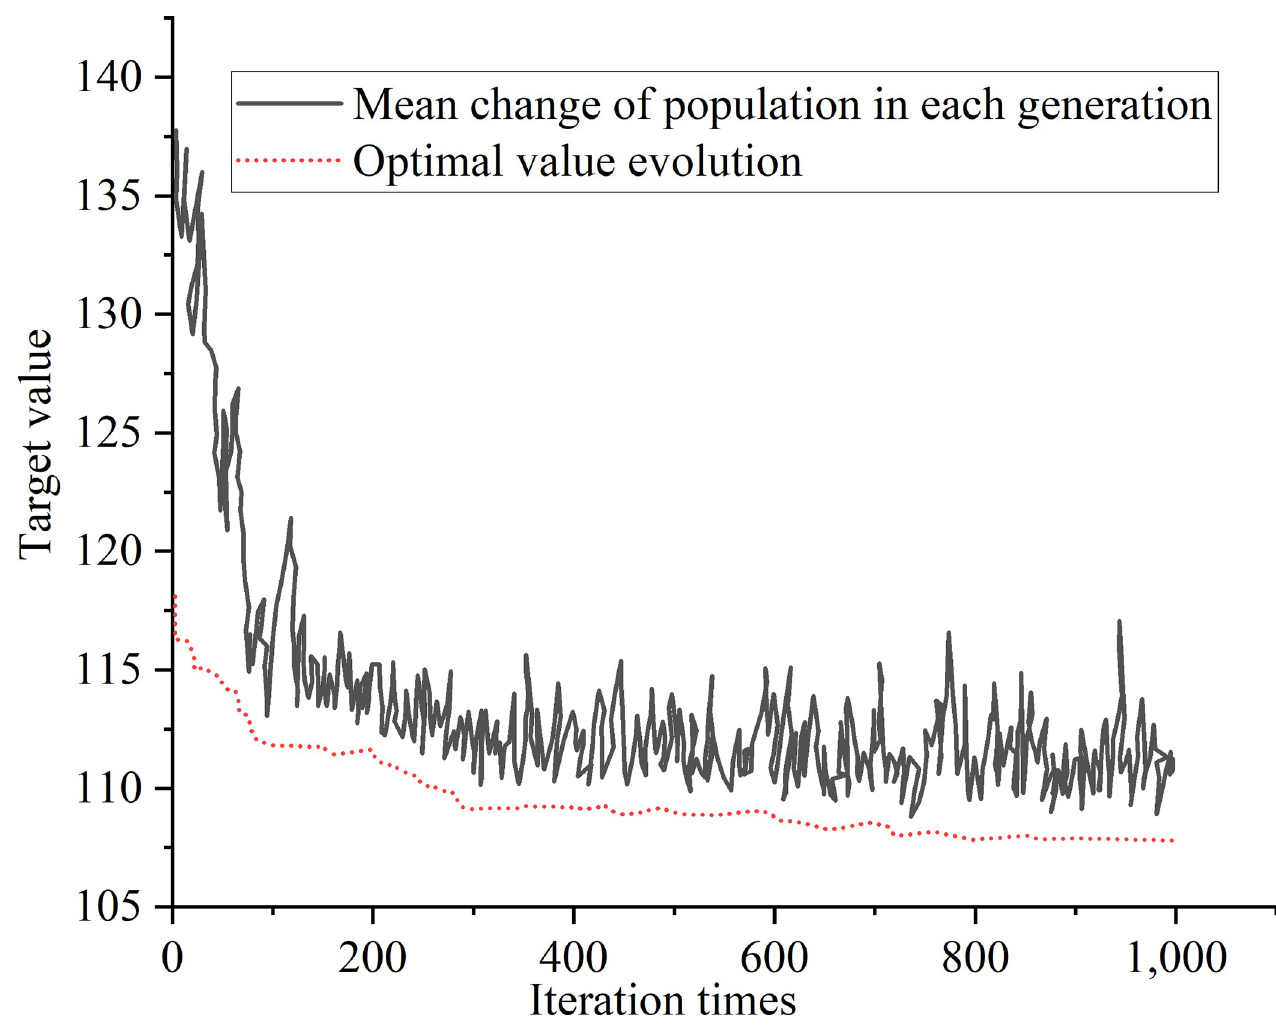
Fig 16. Simulation results of traditional